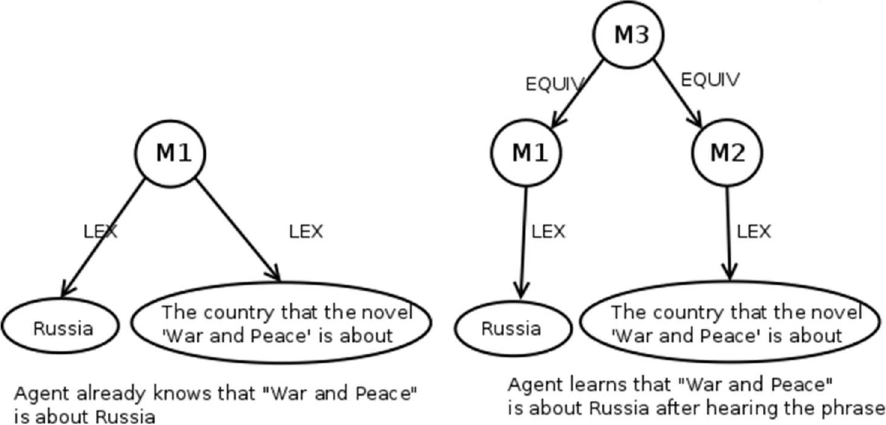
Figure 3. Adding new information to an existing knowledge base. The system does not create a new node (left) or has to create a new node for the utterance